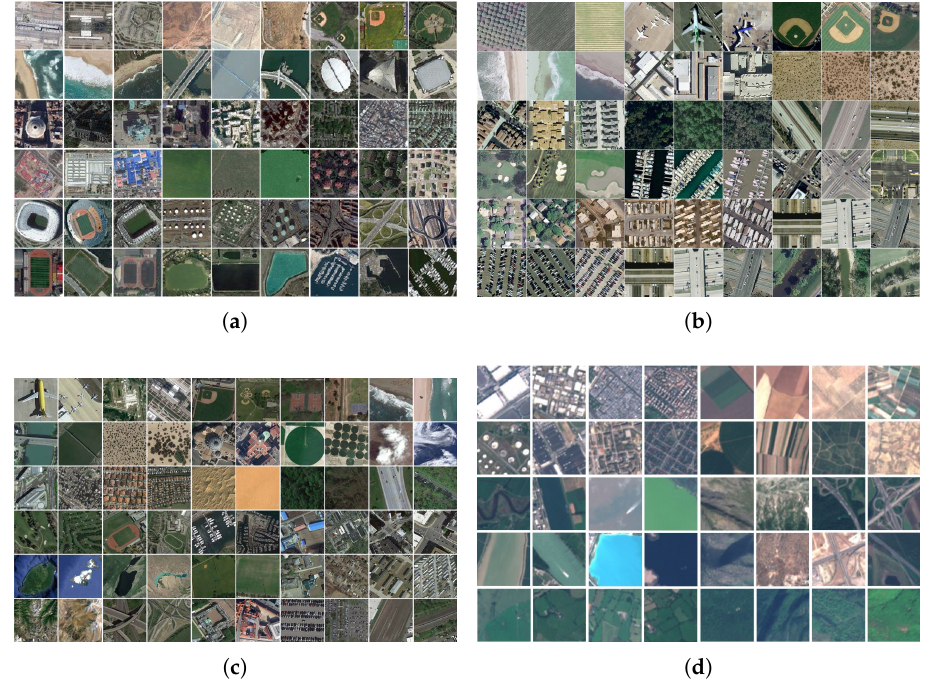
Figure 3. Sample images in ( a ) AID dataset; ( b ) UCMerced dataset; ( c ) NWPU-RESISC dataset; and ( d ) EuroSAT